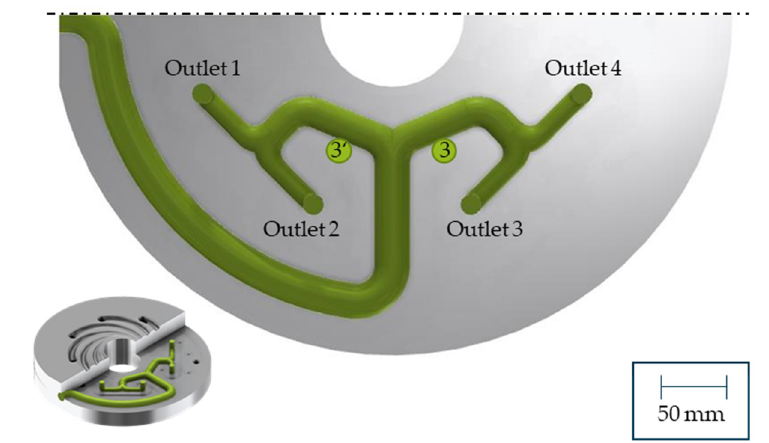
Figure 16. Heat pipe position for two heat pipes.